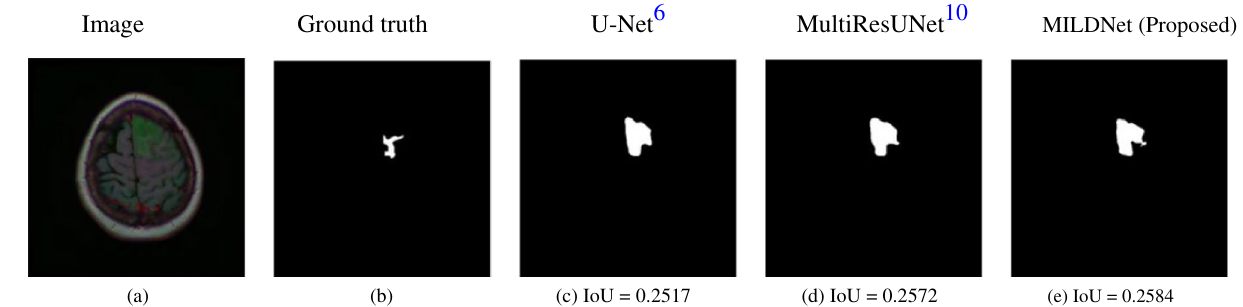
Figure 12. Segmenting a very challenging MRI 15 image (a) having indistinguishable boundaries between the background and the foreground, with (b) being the ground-truth. All models including the proposed approach have over-segmented the image (c–e) .